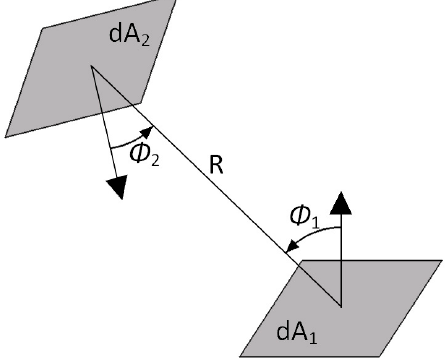
Figure 3. Defining geometry for configuration factor.